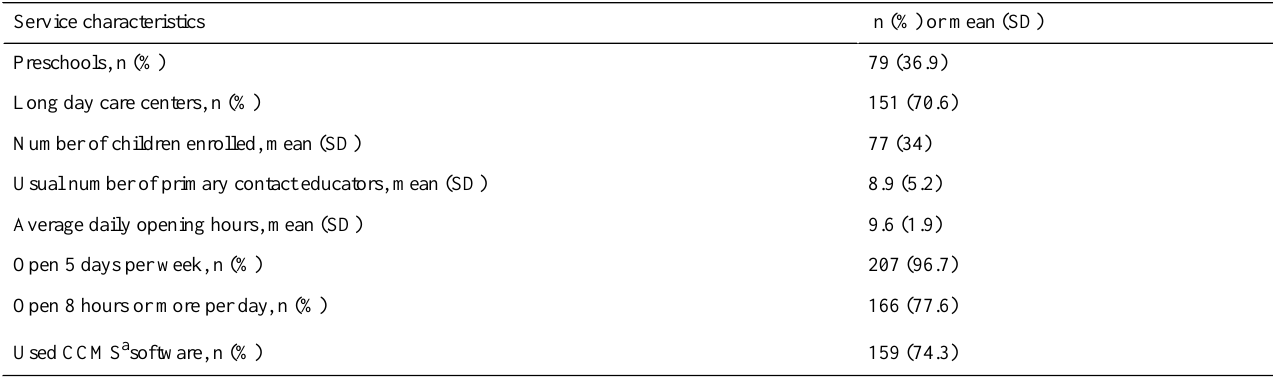
Table 1. Descriptive characteristics of participating center-based childcare services (n=214).